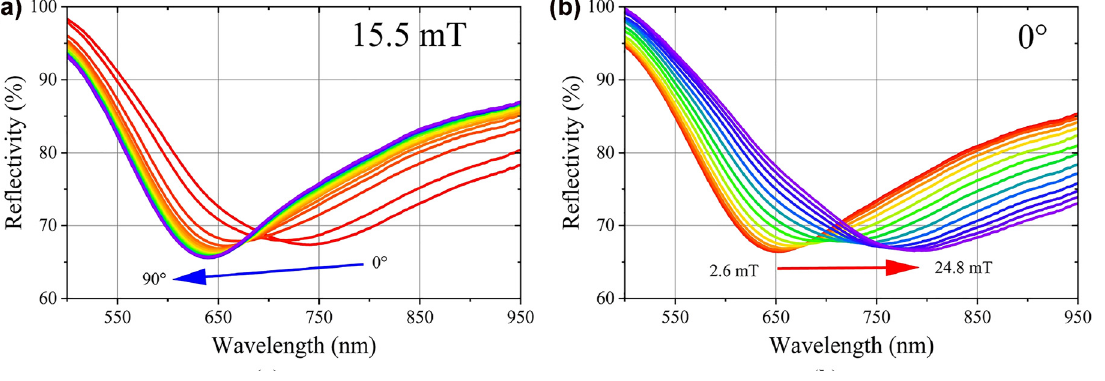
Figure 11: Reflectance spectrum for the as-fabricated sensing probe at different magnetic field direction ( B = 15.5 mT) (a) and different magnetic field intensities ( 𝜃 = 0 ◦ )